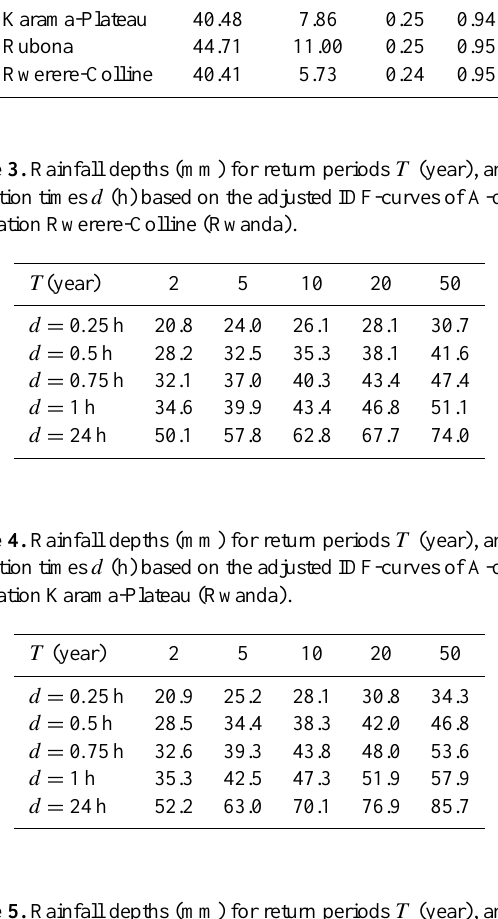
Table 5. Rainfall depths (mm) for return periods T (year), and ag- gregation times d (h) based on the adjusted IDF-curves of A-data at the station Rubona (Rwanda).